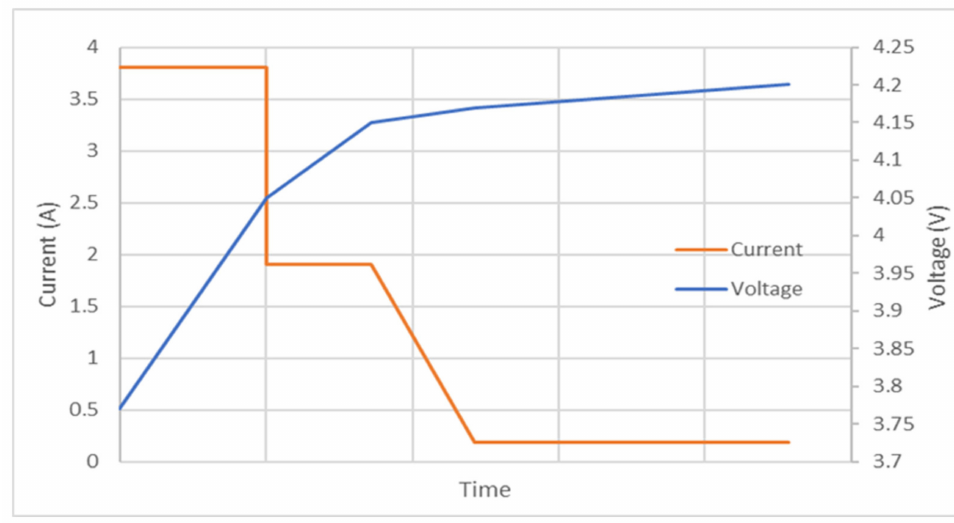
Figure 2. Charge cycle